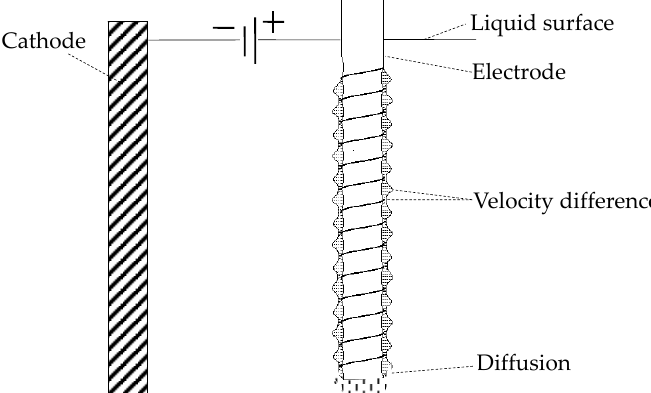
Figure 3. Machining schematic diagram of the spiral cylindrical electrode.